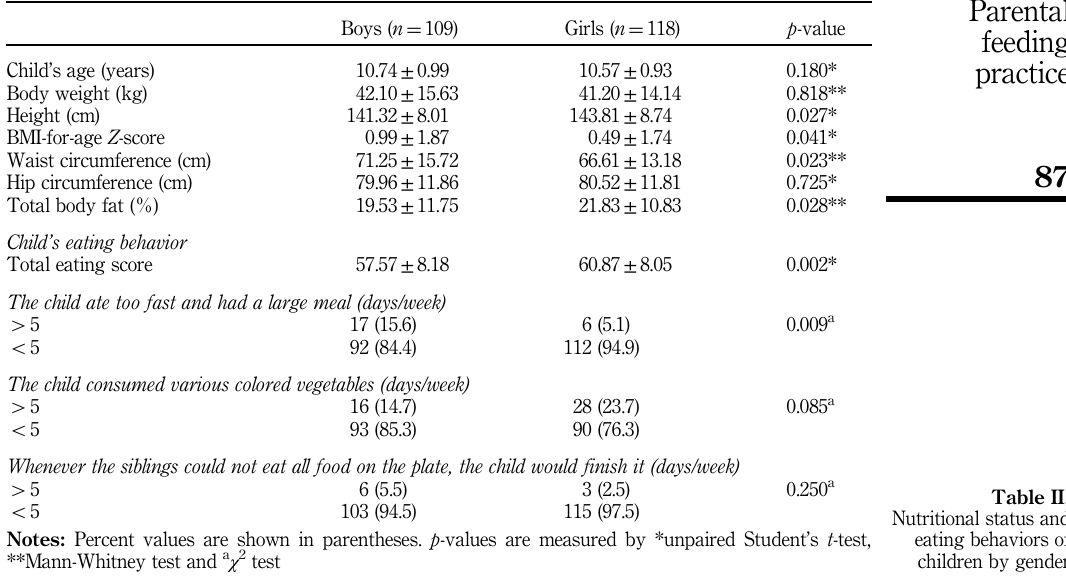
Table II. Nutritional status